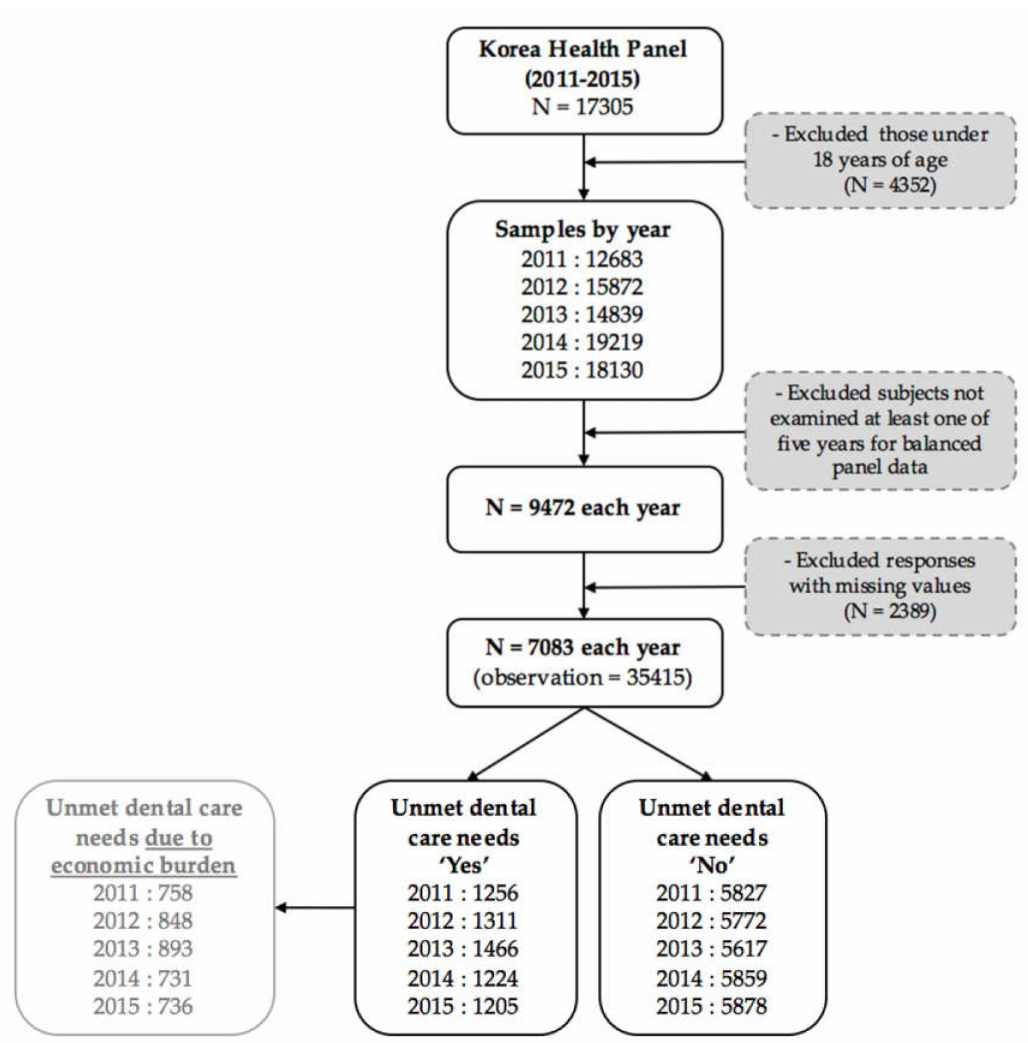
Figure 1. The flow of sample selection in this